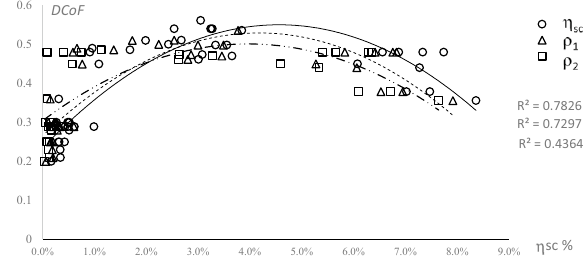
R² = 0.7826 R² = 0.7297 R² = 0.4364